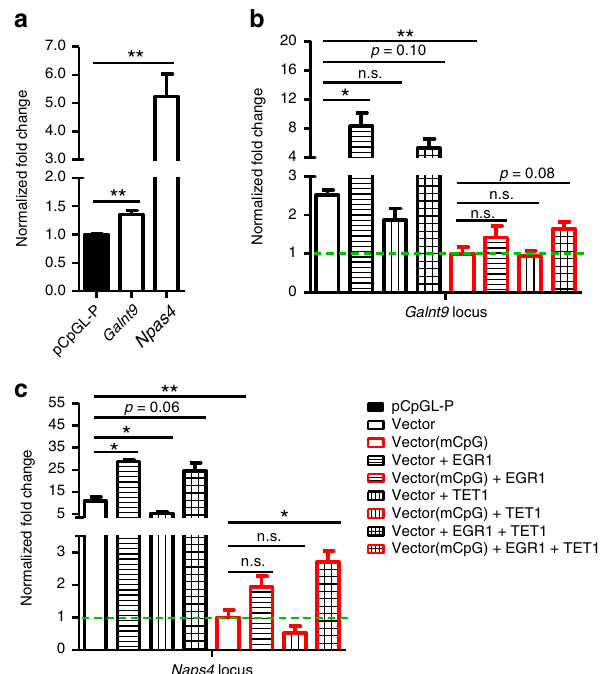
Fig. 4 Cooperativity of EGR1 and TET1 modulate the enhancer activity of EGR1 binding sites. a Luciferase reporter assays for the control vector pCpGL-P and constructs with Galnt9 , Npas4 locus. Fold change was normalized to the control vector pCpGL-P. Luciferase reporter assays for unmethylated or methylated Galnt9 ( b ) and Npas4 ( c ) constructs under either Egr1 / Tet1 singularly or co-expression in primary cortical neurons. In fi gure b – c , fold changes were normalized to the methylated vectors without Egr1/Tet1 overexpression. Luciferase activity was measured at 48 h after transfection and normalized against the activity of a co-transfected fi re fl y construct. mCpG represents methylated constructs. P -values were determined by t -test, * P < 0.05, ** P < 0.01. Values represent mean ±